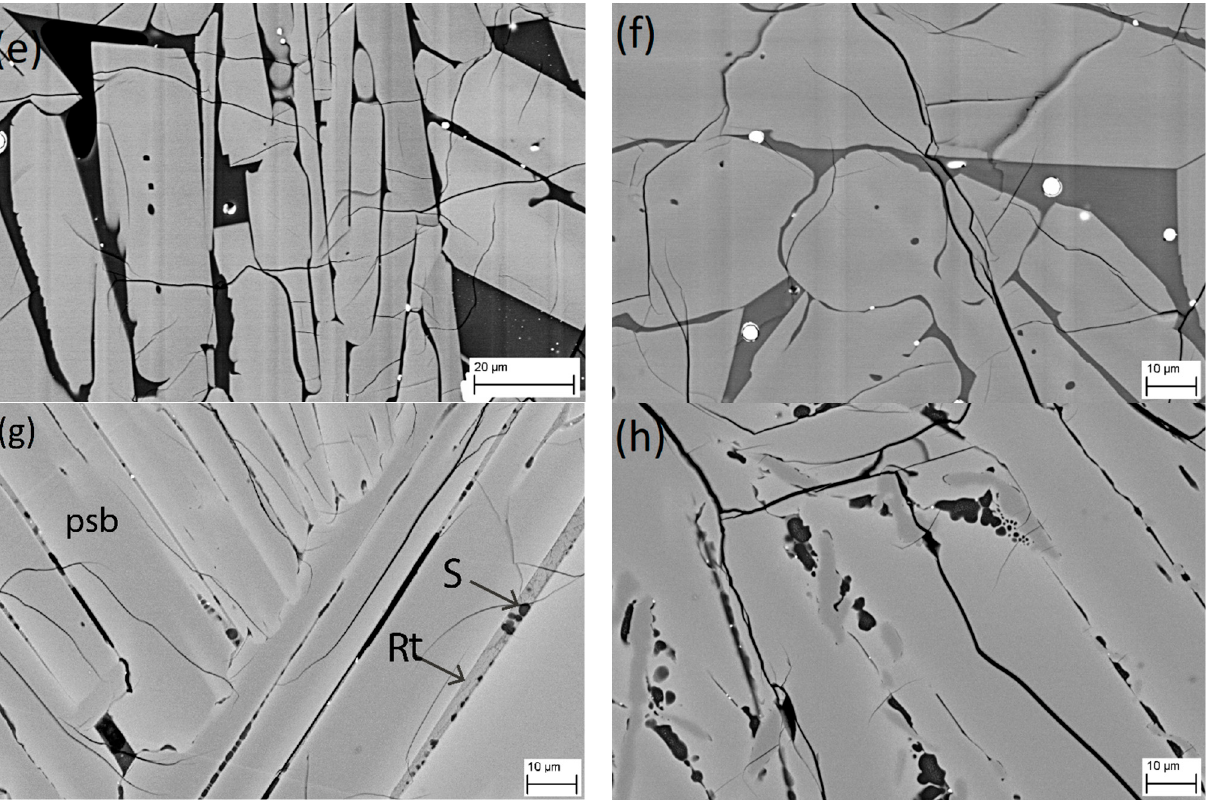
Figure 5. Microstructure of all the samples obtained with SEM at the same magnification of 2500×. The darkest region indicates the silicate phase (S), the medium grey is rutile (Rt) and the lighter region is the pseudo-brookite (Psb). The black lines are the cracks present on the surface. ( a ) Sample 1 ( b ) Sample 2 ( c ) Sample 3 ( d ) Sample 4 ( e ) Sample 5 ( f ) Sample 6 ( g ) Sample 7 ( h ) Sample 8.